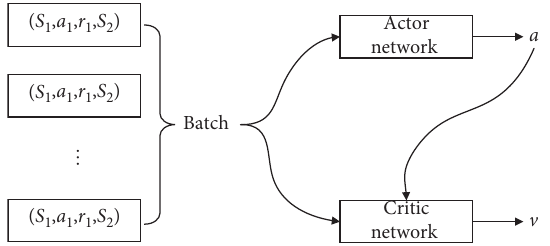
Figure 3: Advantage actor-critic